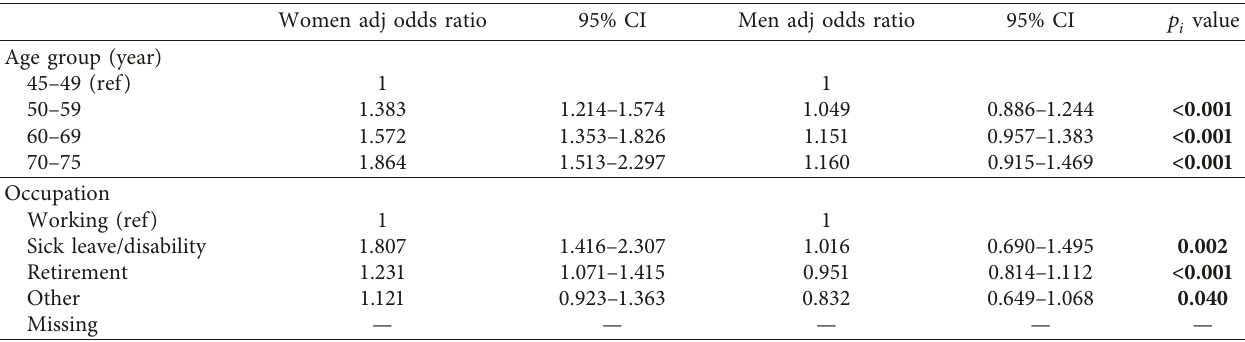
Table 4: Associations between lower versus higher BMI and sociodemographic factors in relation to sex in the EpiHealth cohort.